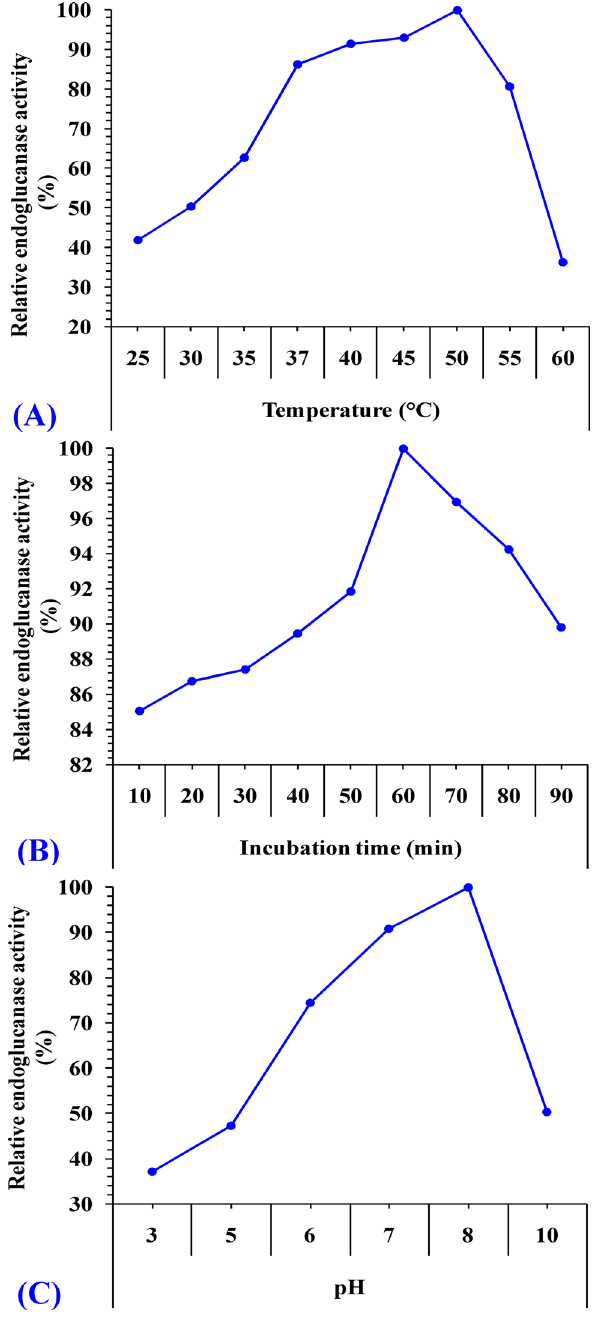
Figure 9. Physicochemical characterization of endoglucanase enzyme ( A ) Relative activity of endoglucanase as a function of the temperature of the reaction ( B ) Relative activity of endoglucanase as a function of the time of the reaction ( C ) Activity of endoglucanase as a function of the pH of the